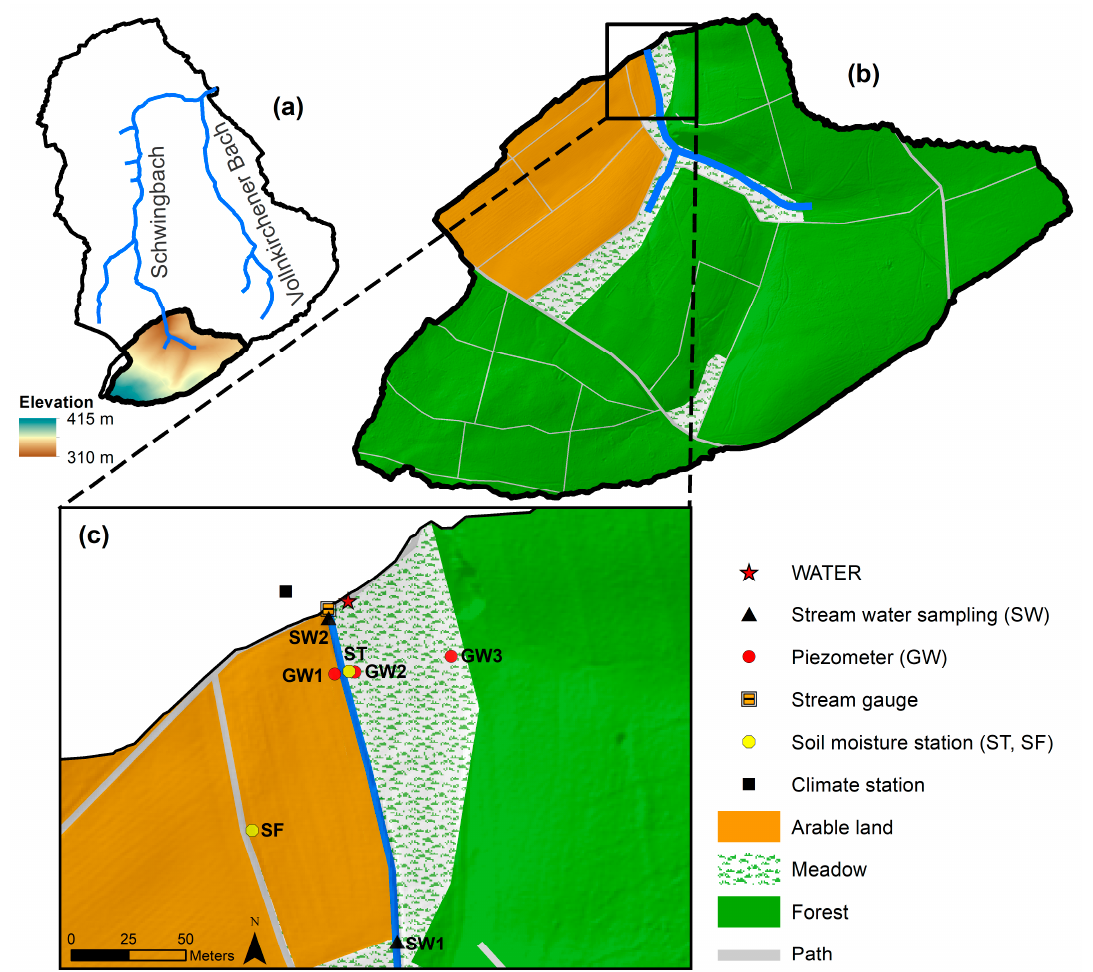
Figure 1. ( a ) Schwingbach Environmental Observatory (SEO), ( b ) Study area in the Schwingbach headwater and ( c ) Measuring network along the stream reach of the Schwingbach headwater. ST and SF are the soil moisture stations at the toeslope and footslope, respectively.